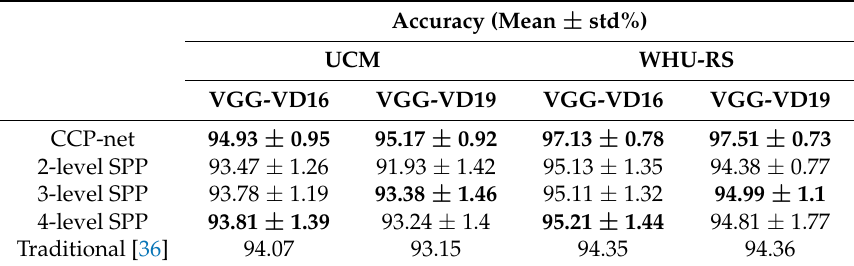
Table 1. The comparison of the classification accuracy with spatial pyramid pooling network.